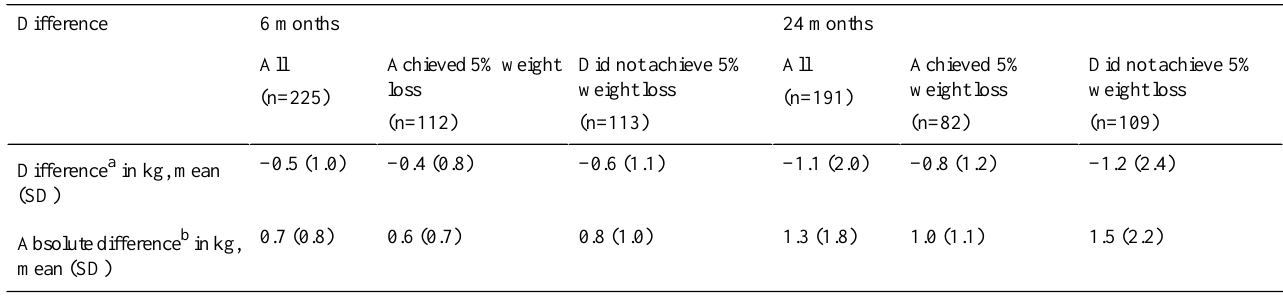
Table 1. Difference in weights (self-reported – clinic) by attainment of 5% weight-loss goal at 6 and 24 months.